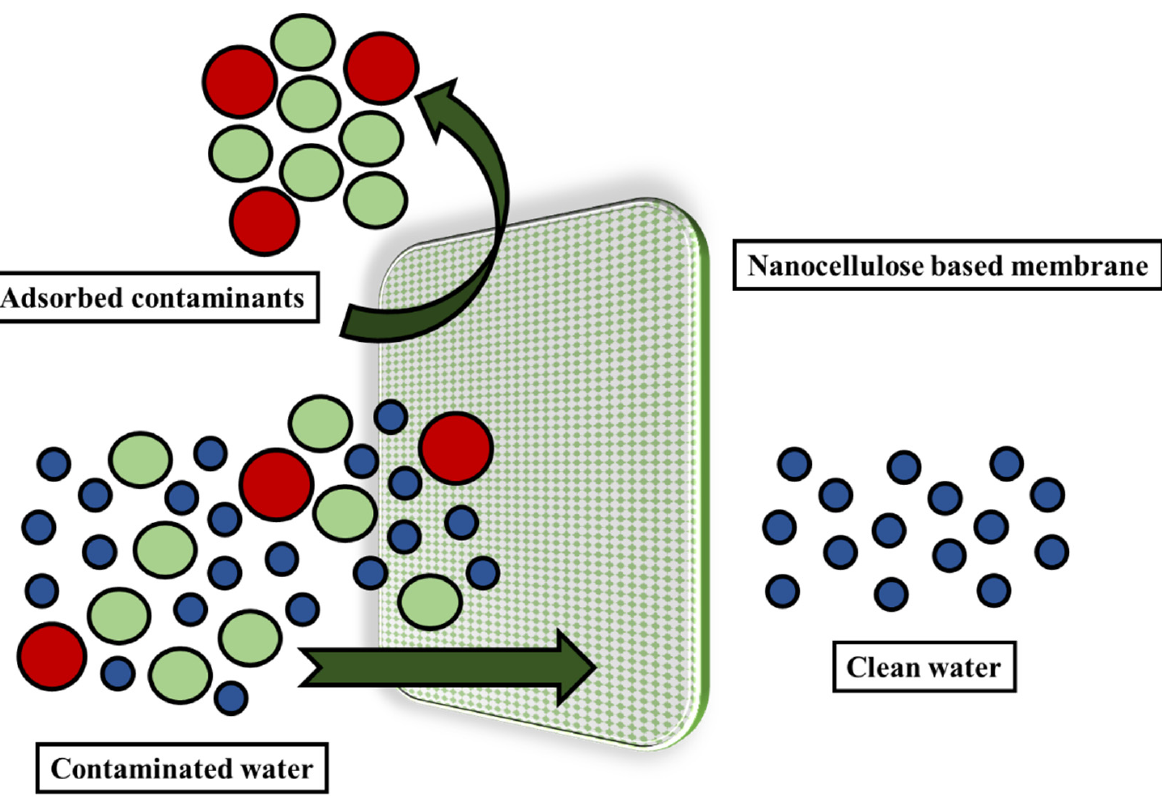
Figure 10. Schematic showing nanocellulosic membranes used to remove water contaminants.